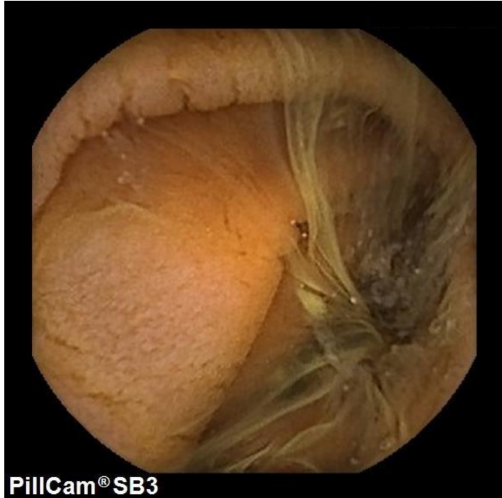
Figure 3. Mucosa atrophy of the small